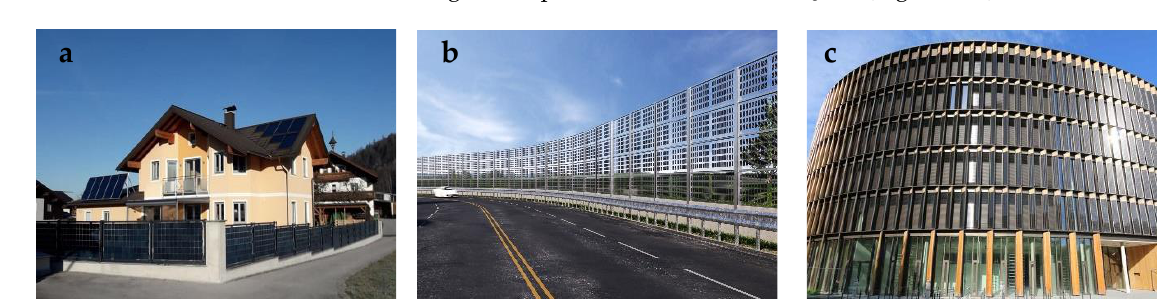
Figure 15. Bifacial photovoltaic modules placed vertically as a solar fence ( a ) [107], noise barrier ( b ) [118], and integrated building PV ( c ) [119].